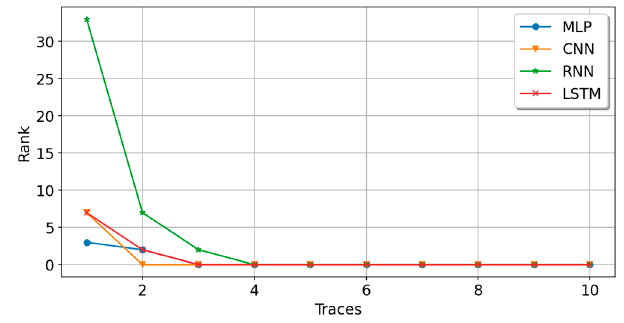
Figure 14. The rank of the four models.